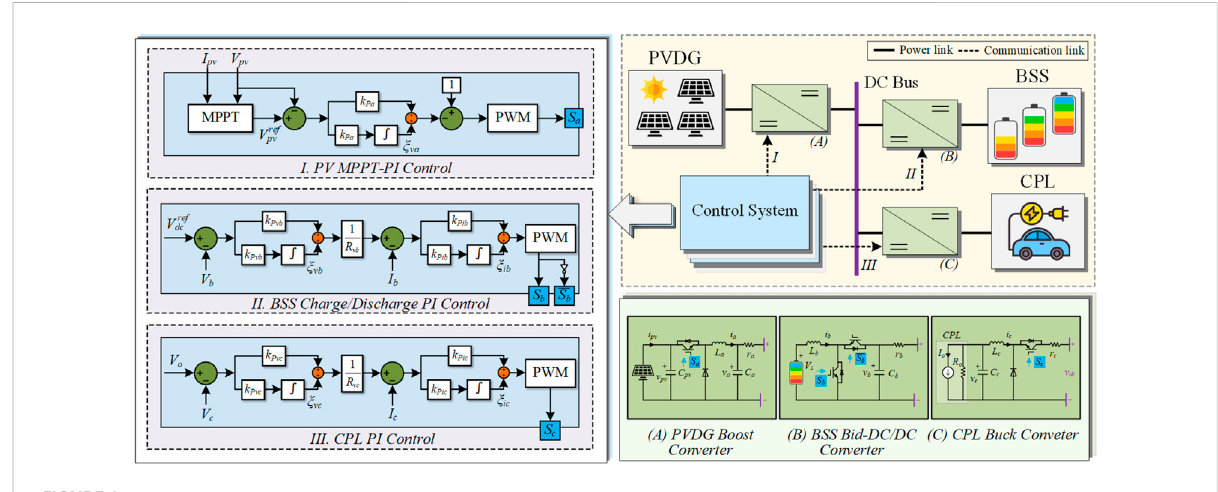
FIGURE 1 Structure of the PV-battery-load-based DC microgrid